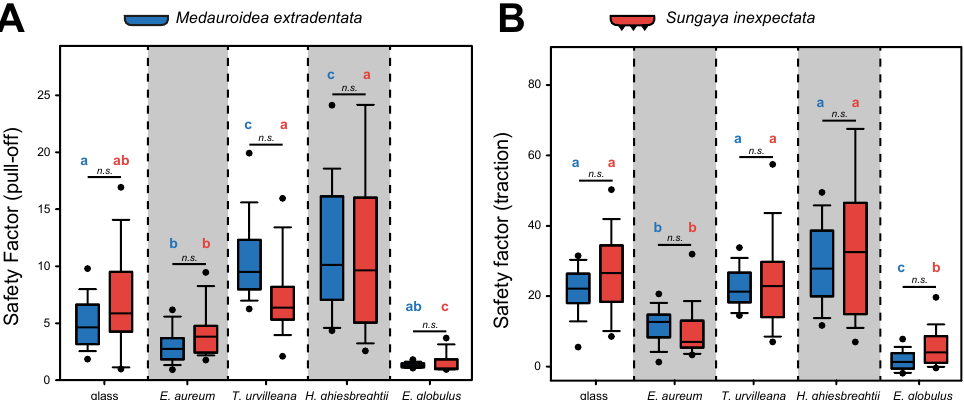
Figure 4. Force measurements on M. extradentata (blue) and S. inexpectata (red). ( A , B ) Safety factors: ( A ) pull-off force, ( B ) traction force. Statistically equal groups within each species are marked with the same letter and between the species with n.s. in comparison on the same substrate. Kruskal–Wallis one-way ANOVA on ranks, ( p ≤ 0.001; pull-off: H = 287.832, d.f. = 9, N = 15; traction: H = 269.977, d.f. = 9, N = 45) and Tukey’s test ( p < 0.05). The boxes indicate the 25th and 75th percentiles, whiskers define the 10th and 90th percentiles and the line within the boxes represents the median. Outliers are shown as individual